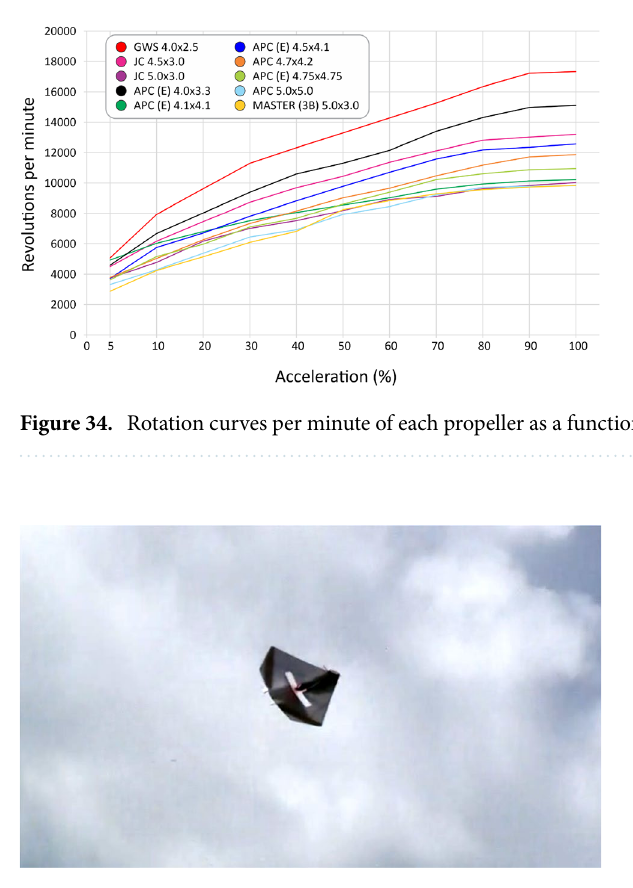
Figure 35. Picture from experimental flight performed (video with about 4 min of flight duration available at https:// youtu. be/ 5nNde